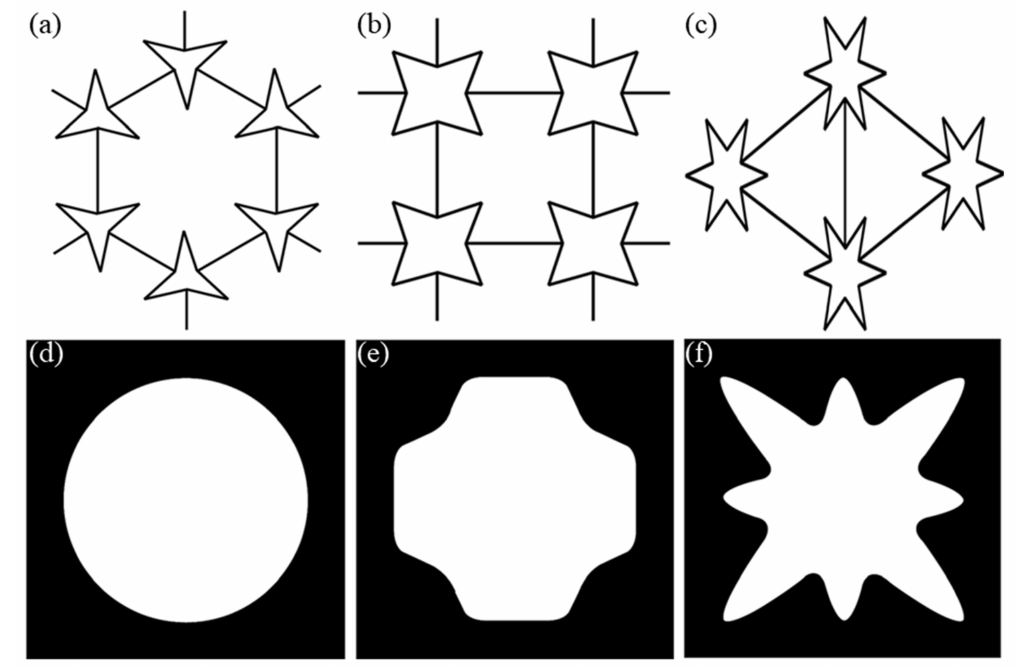
Figure 11. Re-entrant honeycomb structure: ( a ) 3-star, ( b ) 4-star, and ( c ) 6-star system [64]. Void shapes in 2D soft materials ( d ) exhibiting the highest sti ff ness, ( e ) exhibiting the greatest auxetic response, and ( f ) showing the least compaction with positive Poisson’s ratio